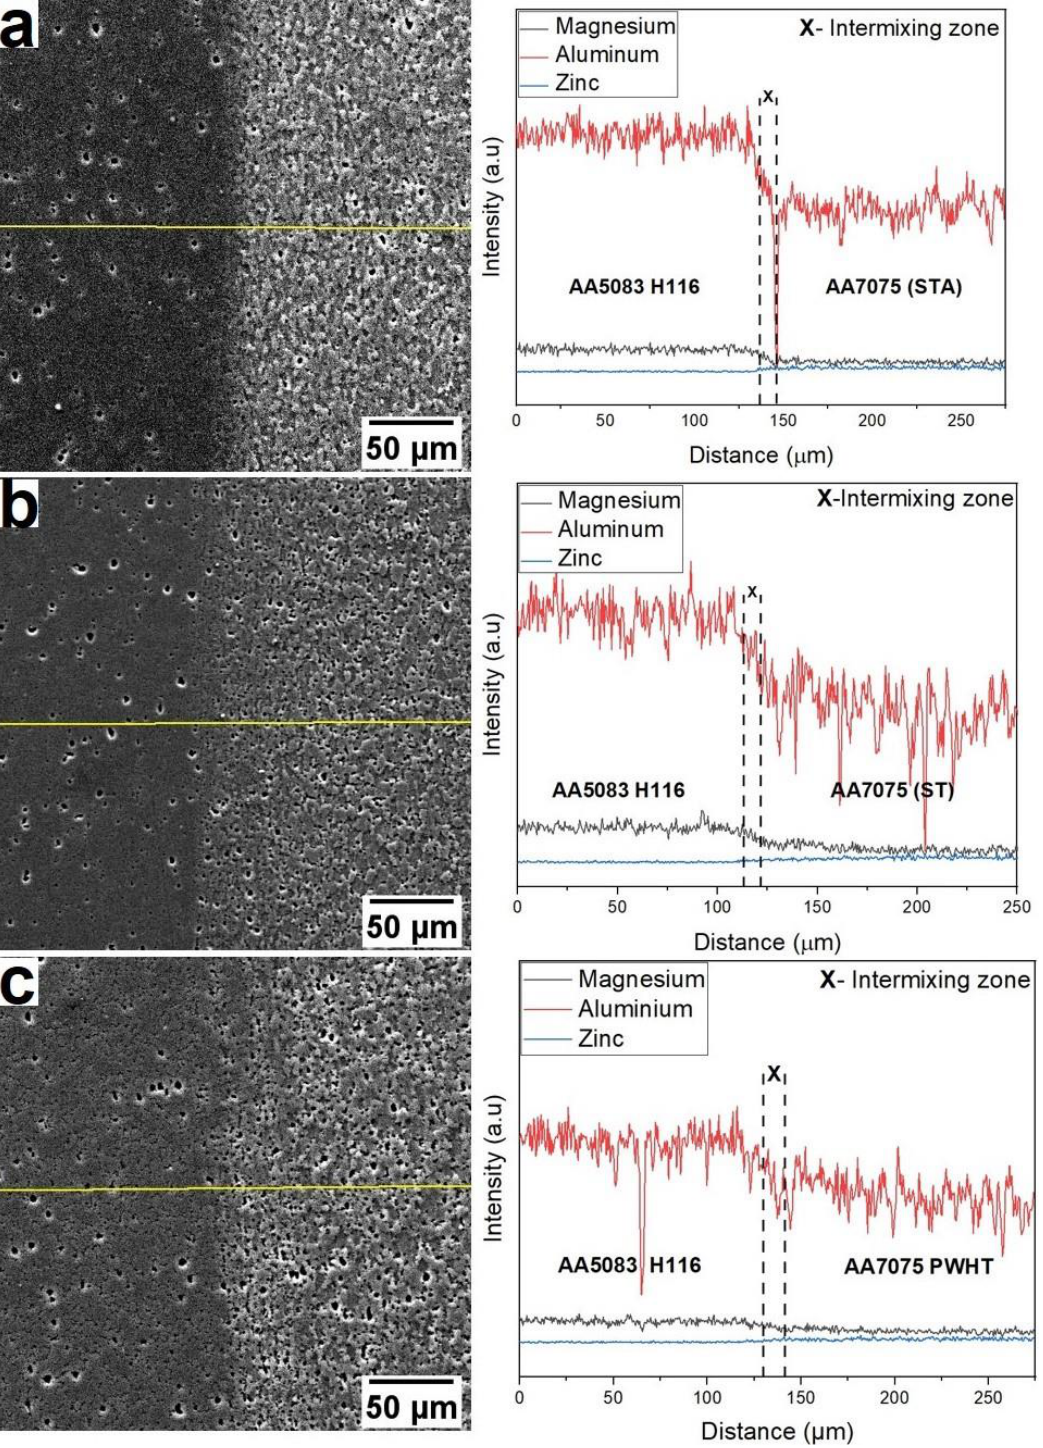
Figure 11. EDS (line scan) microanalysis: elemental distribution across weld interface ( a ) EDS (line scan)